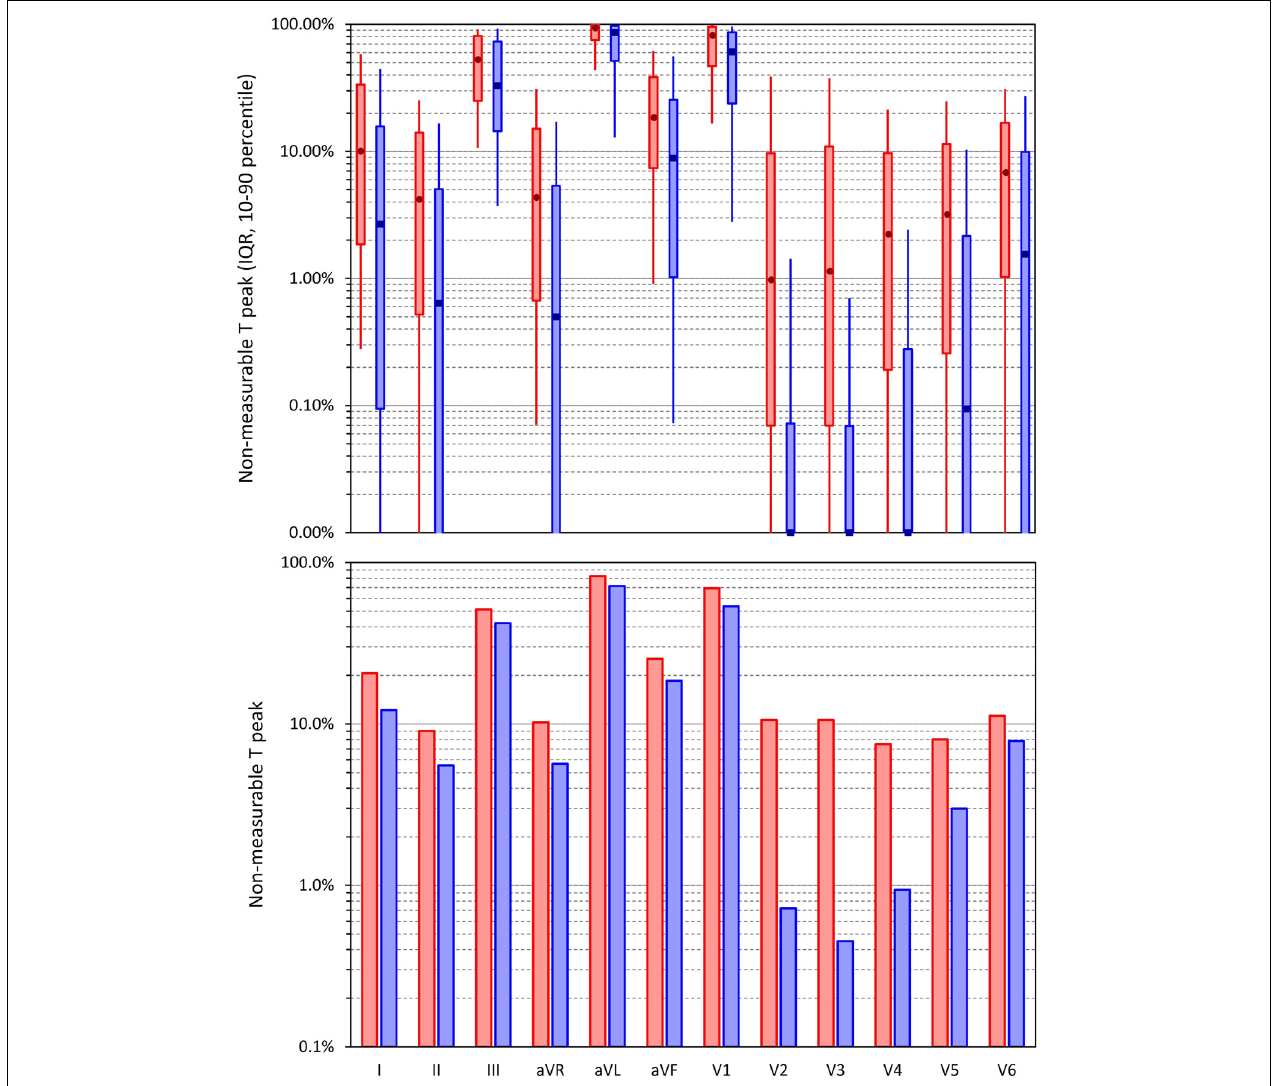
FIGURE 2 | Incidence of non-measurable peaks of the T wave in standard electrocardiogram (ECG) leads. The bottom panel shows the incidence among all ECG segments investigated in the study pooled together; the top panel shows the summary of the incidence in individual study subjects—the bars show the interquartile ranges, and the error bars the spreads between the 10th and 90th percentiles of the population. The dark marks in the middle of the bars are the population medians. In both panels, the displays in red and blue show the data in female and male subjects, respectively. Note the logarithmic vertical axes (in the top panel, there were only 0 display values below